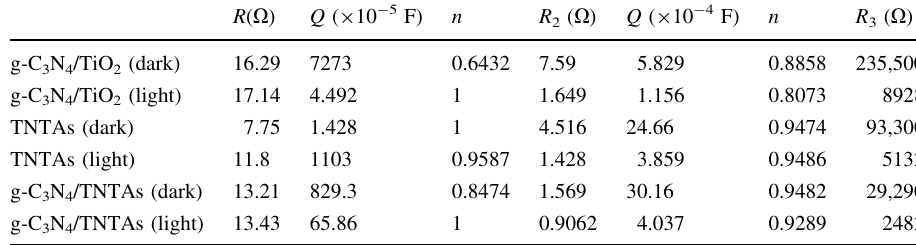
Table 1 Z -fit equivalent circuit